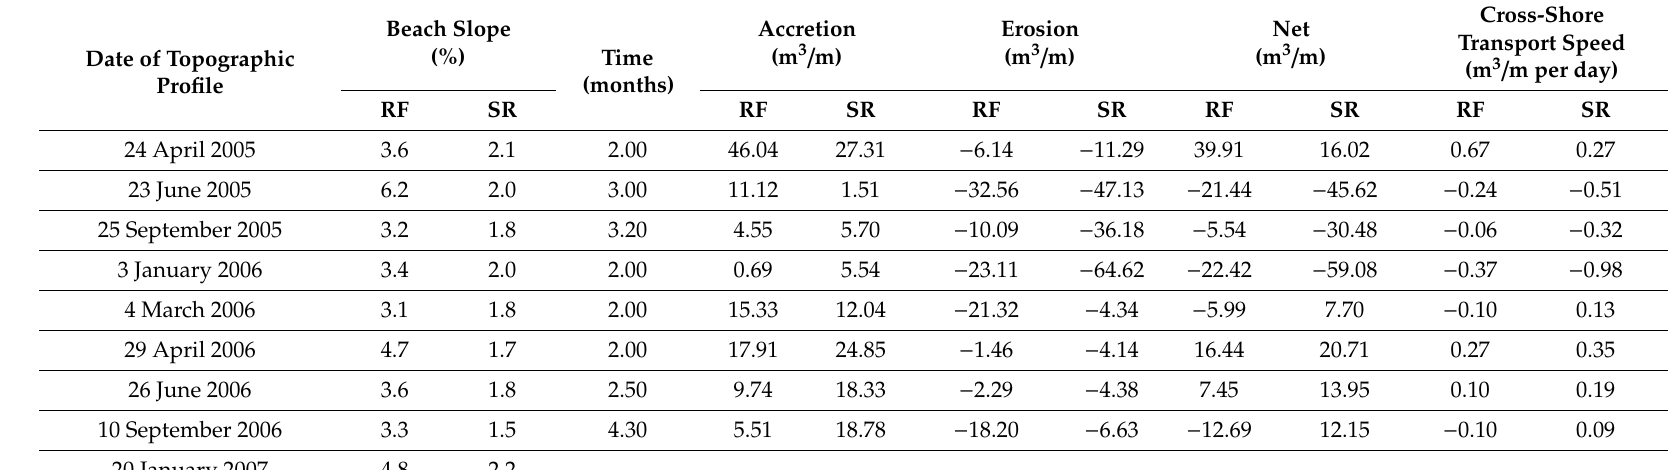
Table 1. Volume rates of the Asilah (reef flat (RF)) and Charf el-Akab (sand-rich (SR)) beaches’ mean profiles. The accretion volume between dates is represented as positive values (m 3 / m) and the volume eroded as negative values (m 3 / m). Cross-shore transport speed (m 3 / m per day) has been calculated as the net value of accretion less erosion (m 3 / m) divided by the time increment in